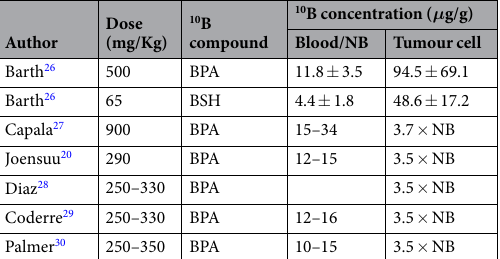
Table 1. A summary of 10 B concentrations in normal brain (NB)/blood and tumour cells.